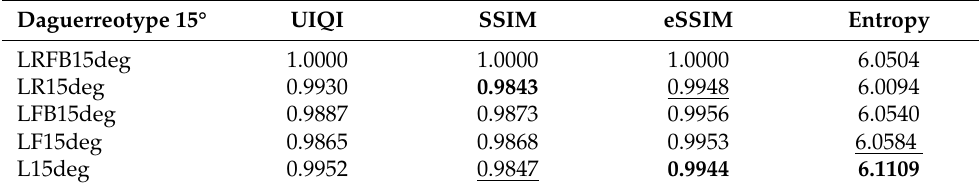
Table 4. Daguerreotype 15°. Comparison of images scanned in different scan modes with a reference image scanned in LRFB 15° mode.